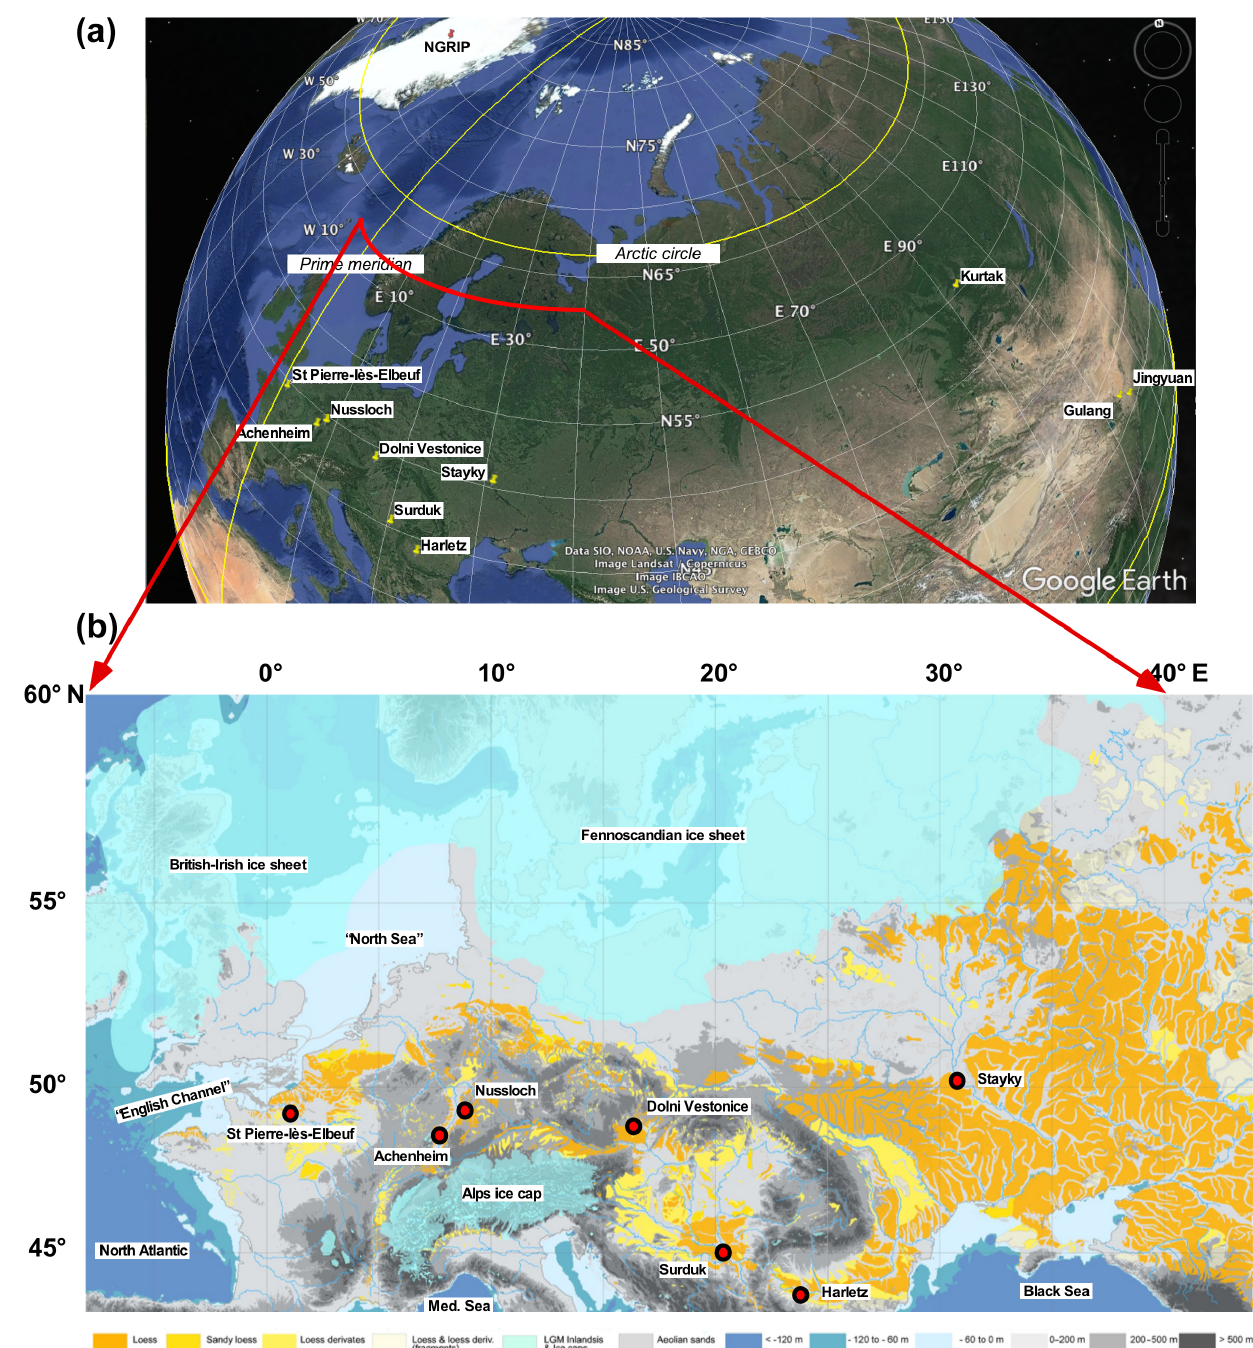
Figure 1. Studied records in this paper. (a) Location of the different records over Greenland and Eurasia. (b) Map of the European loess. Indi- cation of the depth of the last glacial maximum sea level low stand and of the expansion of the Greenland, Iceland, British, and Fennoscandian ice sheets. Location of European key loess sequences. Map drawn by P. Antoine in Rousseau et al. (2014)